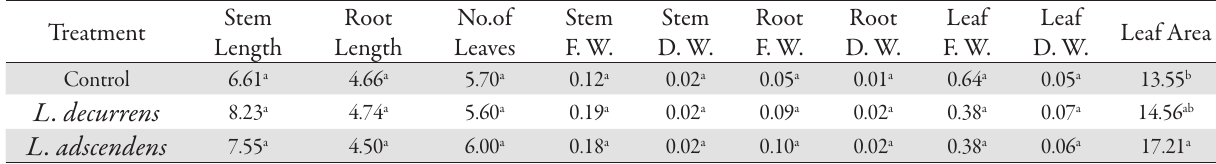
Tab. 2. Effect of Ludwigia decurrens and L. adscendens exudates on vegetative parameters of Corchorus olitorious at week 4